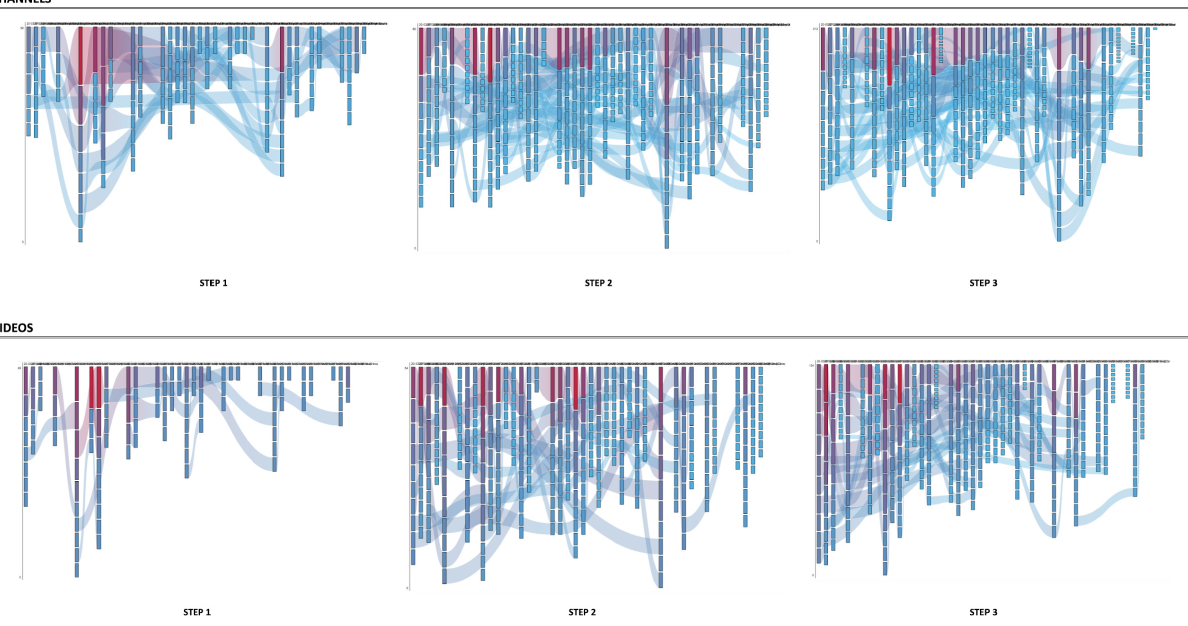
Media and Communication, 2021, Volume 9, Issue 4, Pages